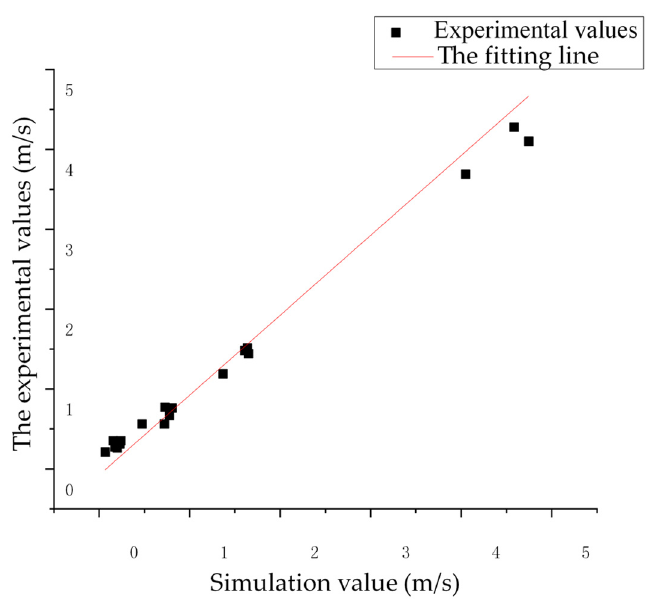
Figure 13. Linear Figure 13. Linear fitting